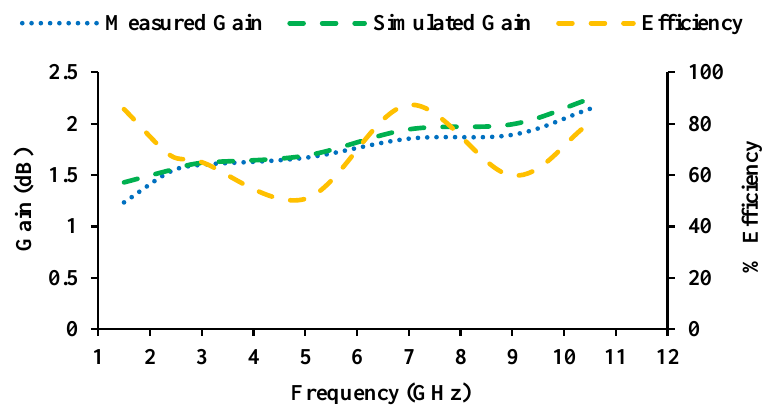
Figure 13. Measured gain and efficiency of the designed antenna.